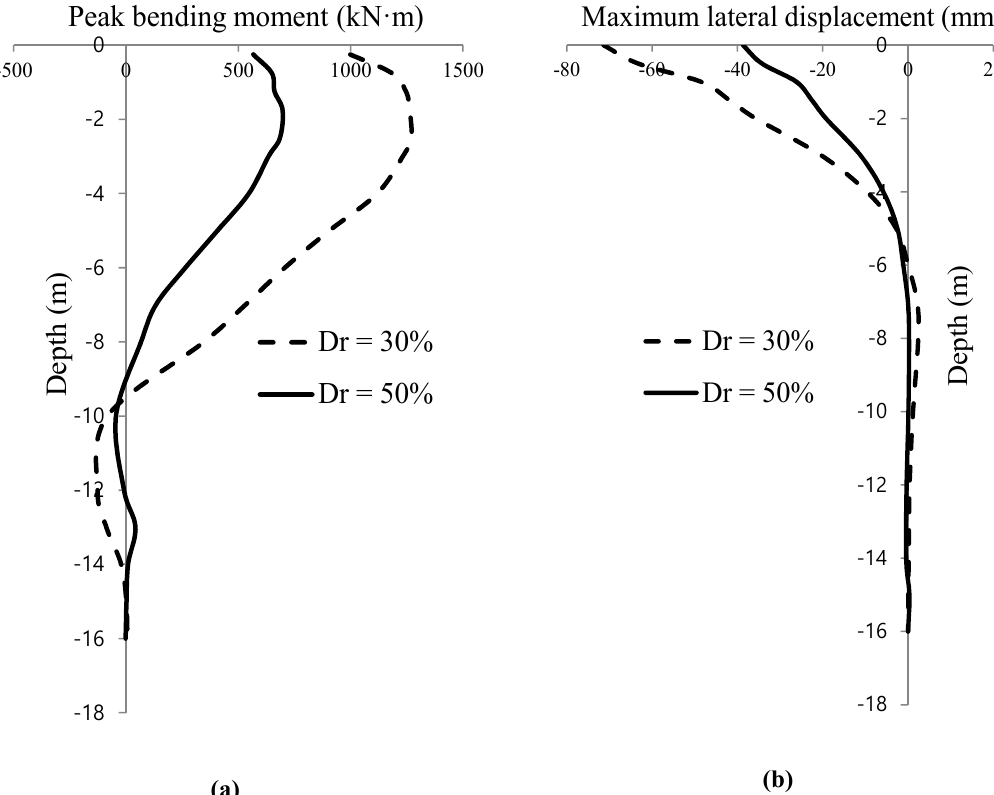
Figure 13. Dynamic pile response envelopes according to the relative density in liquefiable condition: ( a ) Peak bending moment along the depth, ( b ) Maximum lateral displacement along the depth